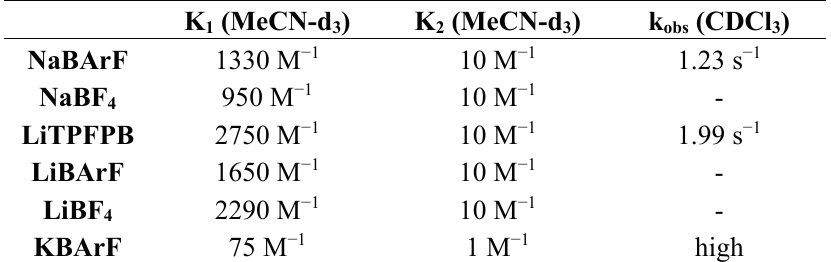
Table 1. Summary of key results. Binding constants K 1 (1:1 complex) and K 2 (1:2 complex, two hosts/one ion) determined by 1 H NMR titration experiments in MeCN-d 3 (estimated error: 10%–20%). Exchange rate k obs determined by EXSY NMR spectroscopy in CDCl 3 (error ca.